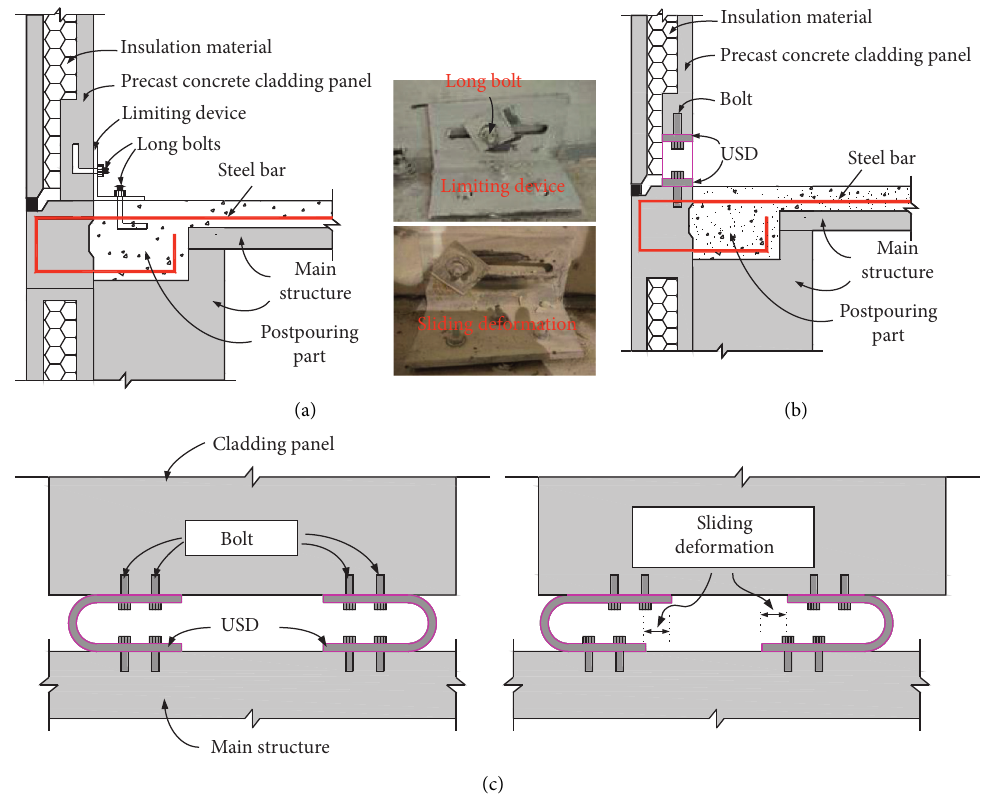
Figure 1: Connection details and deformation mode of the proposed damping cladding panel. (a) Typical cladding connection 2 in China. (b) Connection details. (c) Deformation mode of the proposed damping cladding panel.